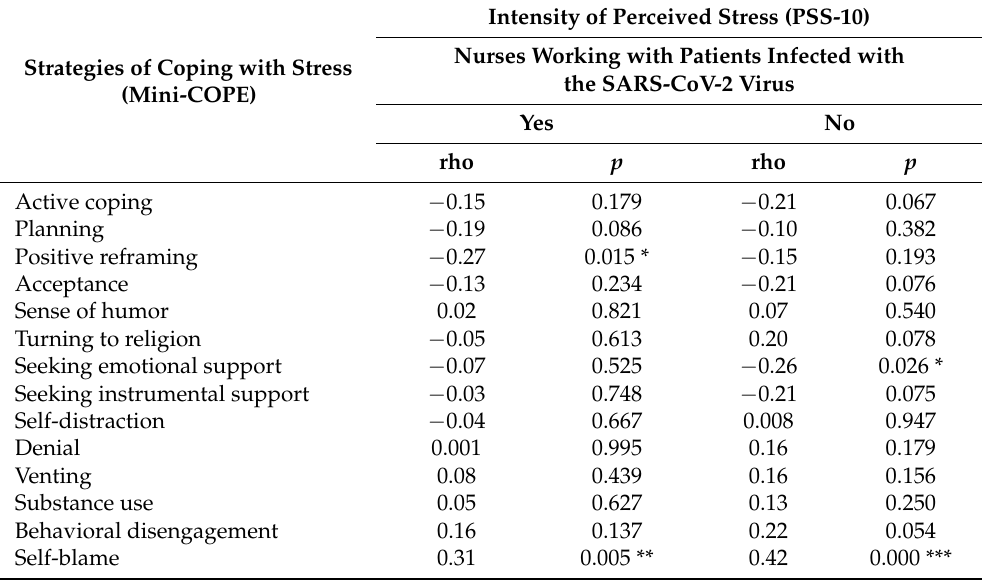
Table 5. Strategies of coping with stress and the intensity of stress perceived by nurses working with patients infected and not infected with the SARS-CoV-2 virus. Intensity of Perceived Stress (PSS-10) Nurses Working with Patients Infected with Strategies of Coping with Stress the SARS-CoV-2 (Mini-COPE)